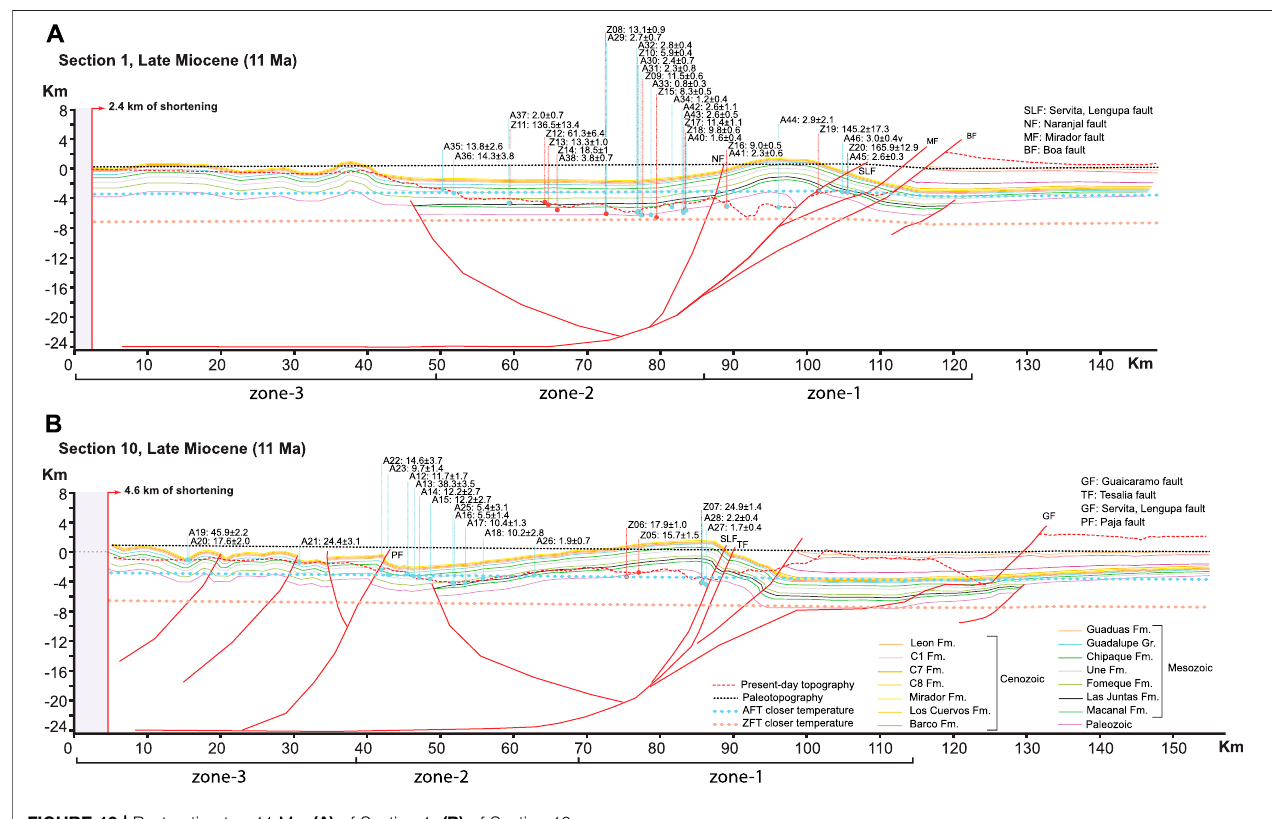
FIGURE 13 | Restoration to ∼ 11 Ma, (A) of Section 1, (B) of Section 10.